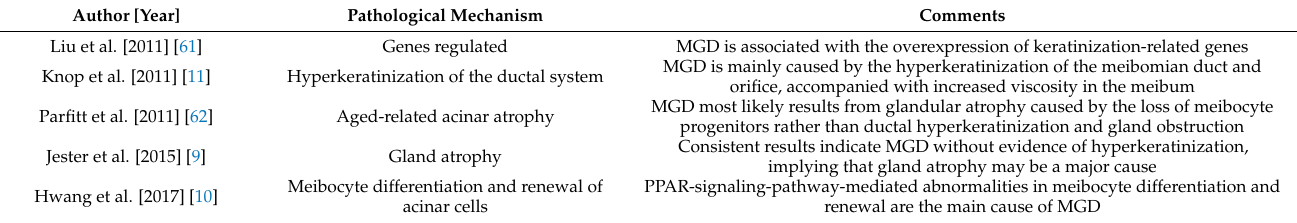
Table 2. Pathological mechanism of MGD.